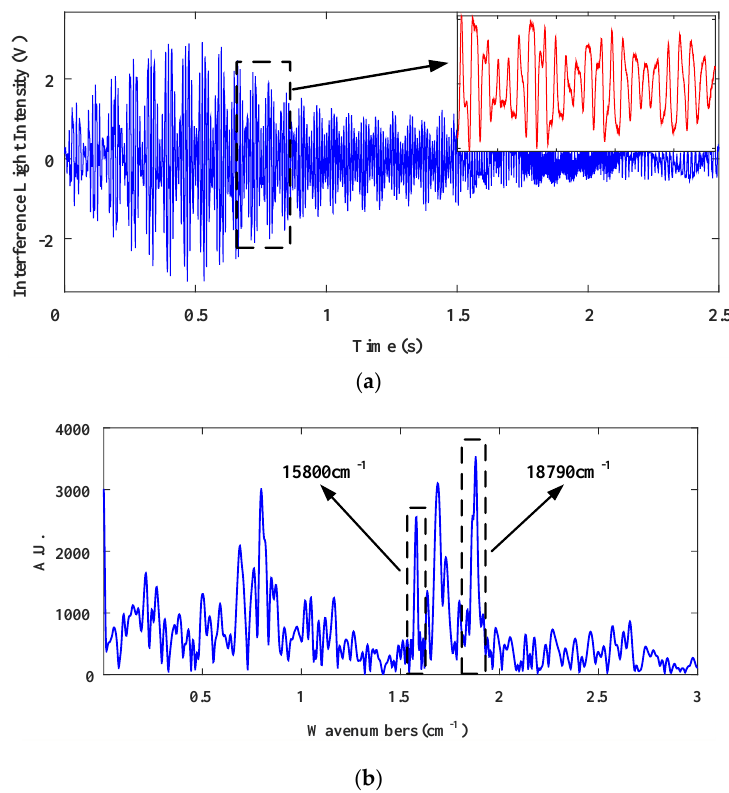
Figure 19. Under look-up table control using different driving ( a ) The interferogram signals of testing light acquired in time domain. ( b ) Spectrum recovered of the testing light.